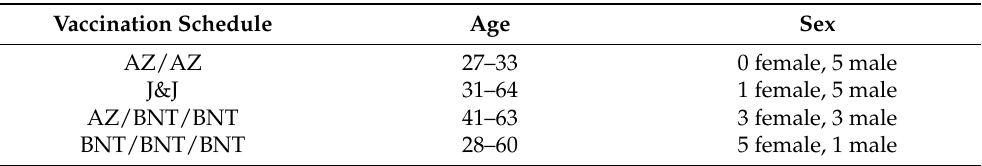
Table 1. Demographics of vaccinated